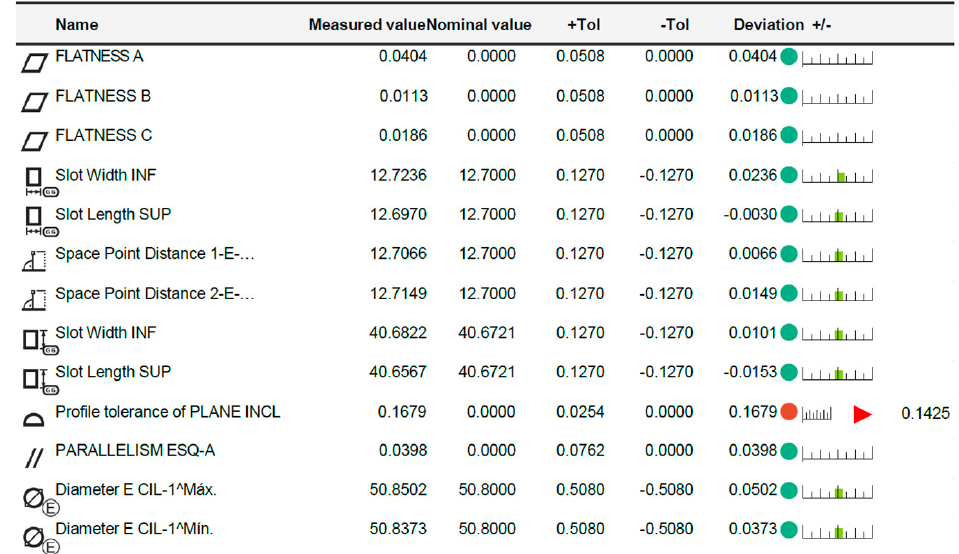
Figure 7. Dummy part calibration on the ZEISS UPMC 850 CARAT CMM.